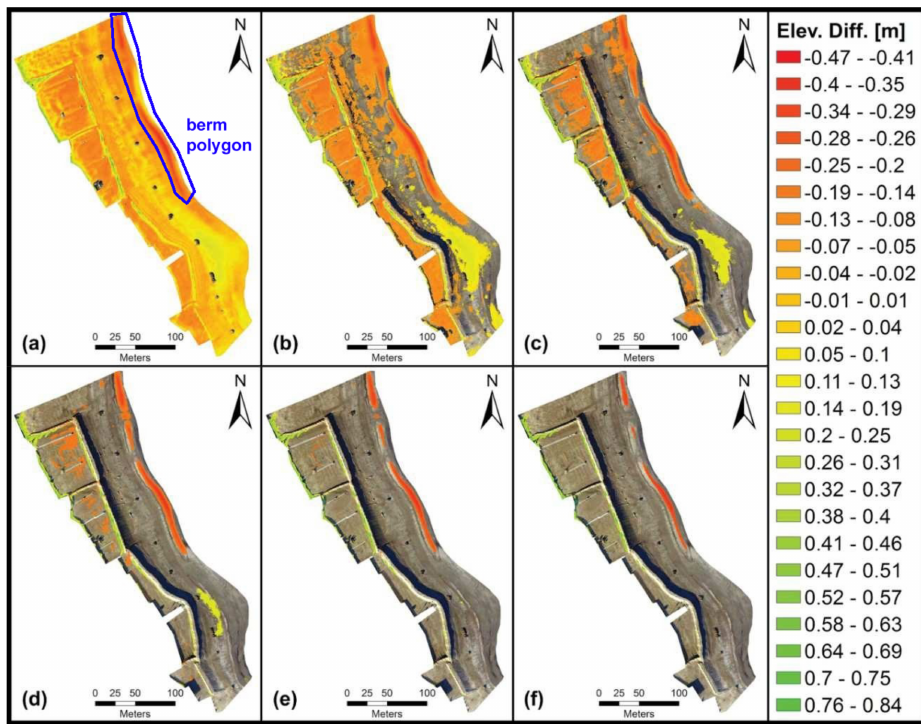
Figure 8. Morphological variations between the survey of 21 December 2016 and 20 January 2017 calculated through the minimum threshold for change detection. The thresholds for change detection are as follows: ( a ) none (the polygon used to calculate morphological changes on the northern berm only is also shown), ( b ) 0.05, ( c ) 0.10, ( d ) 0.15, ( e ) 0.20 and ( f ) 0.25 m. The legend on the right indicates the magnitudes of the variations, which is negative for erosion and positive for deposit.